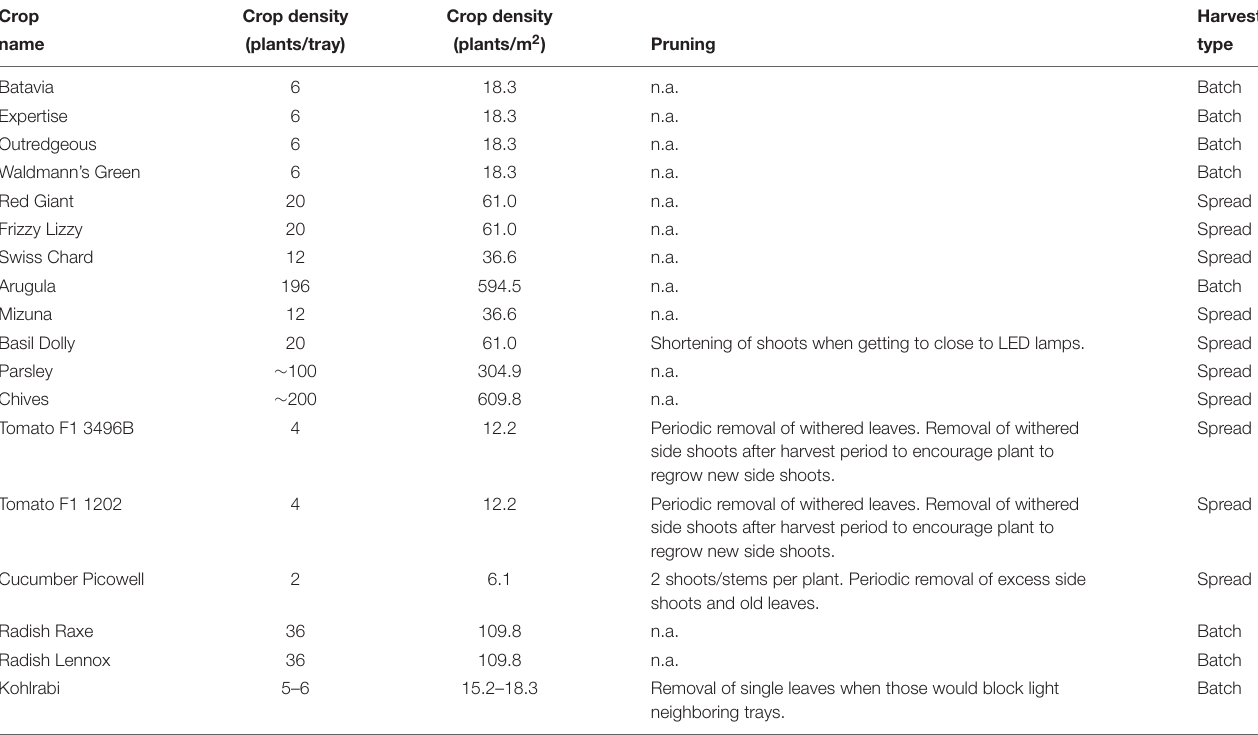
TABLE 1 | Summary of plant treatment information. Crop Crop density